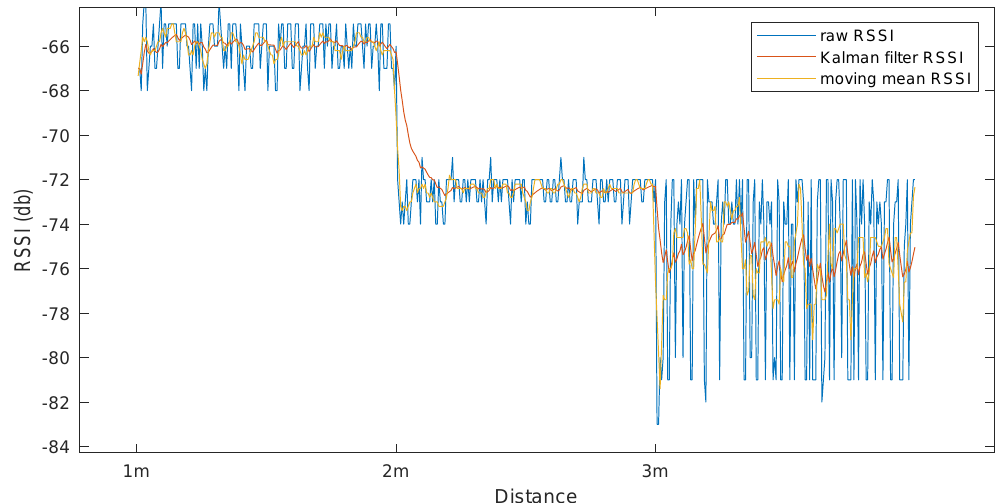
Figure 7. Received signal strength indicator (RSSI) raw data compared to Kalman and moving average filter